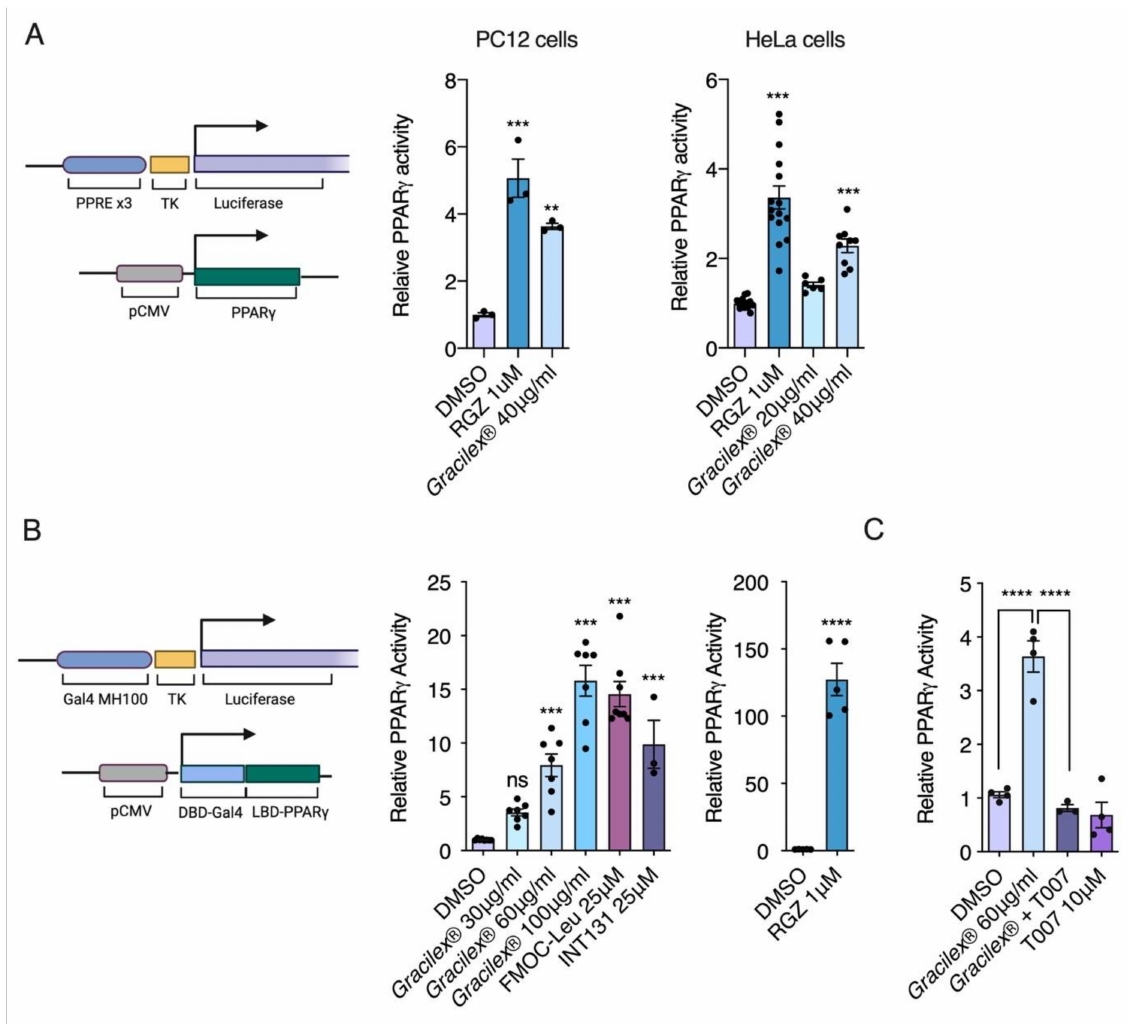
Figure 1. Agarophyton chilense oleoresin (Gracilex ® ) induces PPAR γ transcriptional activation. Two cell-based reporter assays to measure PPAR γ activation were performed. Left panel ( A ): schematic representation of vectors used for co- transfection. PC12 and HeLa cells were cotransfected with plasmids expressing full-length murine PPAR γ and a reporter plasmid containing PPRE (peroxisomal proliferator response element) driving expression of luciferase, together with plasmid expressing beta-galactosidase as transfection control. Full PPAR γ agonist rosiglitazone (RGZ, 1 µ M) and Gracilex ® (40 µ g/mL) induced transcriptional activation of PPAR γ , as shown by increased luciferase activity normalized to beta- galactosidase expression (expressed as relative PPAR γ activity). In PC12 cells ( n = 3) and HeLa cells ( n = 6–13), treatments (RGZ and Gracilex ® ) were compared to control transfected cells (DMSO), and values are presented as ± SEM, ** p < 0.01, and *** p < 0.001 (one-way ANOVA and Tukey’s post hoc test). Left panel ( B ): schematic representation of vectors used for cotransfection. Plasmid with expression of a chimeric construct of PPAR γ ligand binding domain (LBD-PPAR γ ) gene and DNA binding domain of Gal4 (DBD-Gal4) was cotransfected with a plasmid possessing the response element of GAL4 (Gal4 MH100) driving luciferase expression. As in (A), a third plasmid was included with expression of beta-galactosidase as transfection control. Increased PPAR γ activation is expressed as relative PPAR γ activity. Gracilex ® induced dose-response activation of PPAR γ is comparable to activation induced by selective PPAR modulators (SPPARMs) of PPAR γ , FMOC-Leu, and INT131 at a concentration of 25 µ M. Instead, RGZ at 1 µ M shows much higher activation (110 times over control), as expected for a full agonist. Values are presented as ± SEM, n = 3–7, and *** p < 0.001, **** p < 0.0001 left panel: one-way ANOVA and Tukey’s post hoc test; right panel: unpaired t -test). The ( C ) PC12 cells were transfected as described in ( B ) and treated with Gracilex ® (60 µ g/mL) with or without PPAR γ antagonist T0070907 (T007, 10 µ M). Values are presented as ± SEM, n = 4, and **** p < 0.0001 (one-way ANOVA and Tukey’s post hoc